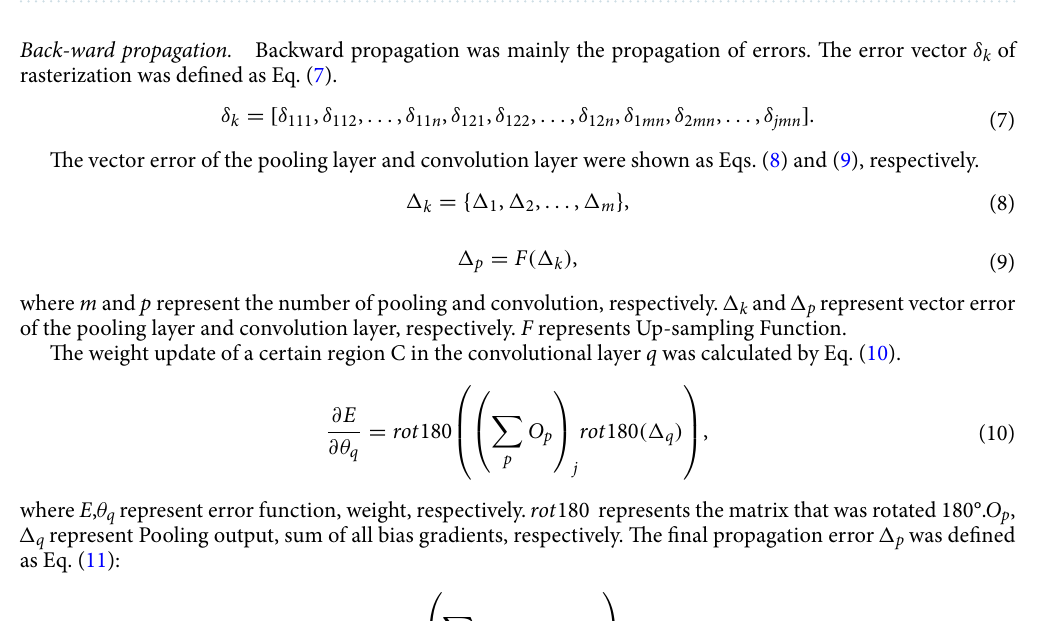
Figure 4. Flowchart of the algorithm for proposed apple identification